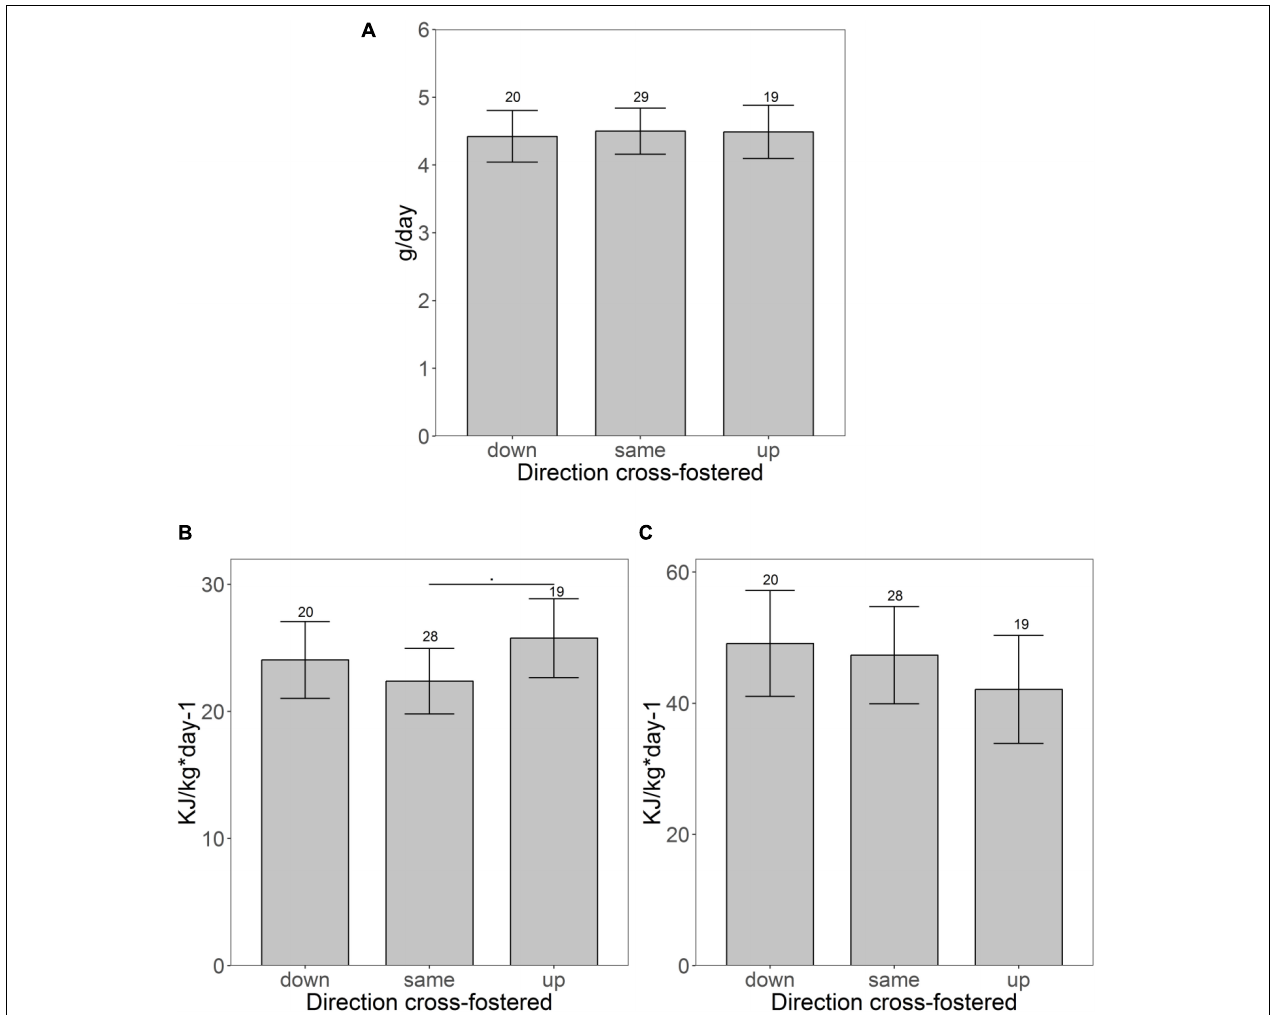
FIGURE 3 | Pups fostered to different size ranks. (A) Shows the growth rates and (B,C) show differences of the specific resting metabolic rate before (B) and after maturation (C) of pups fostered to different size ranks. Shown are the estimated values derived from the mixed models on traits ± confidence intervals. Samples sizes are given above the